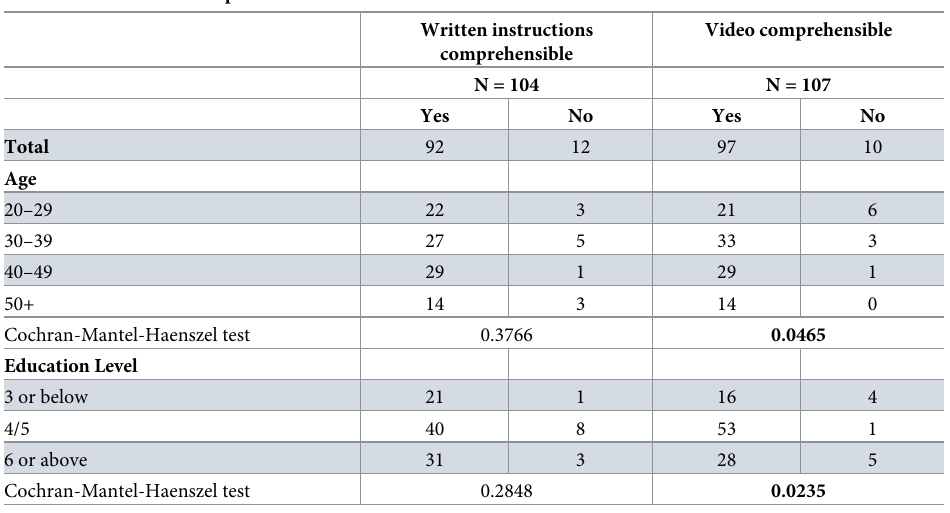
Table 5. Instructions’